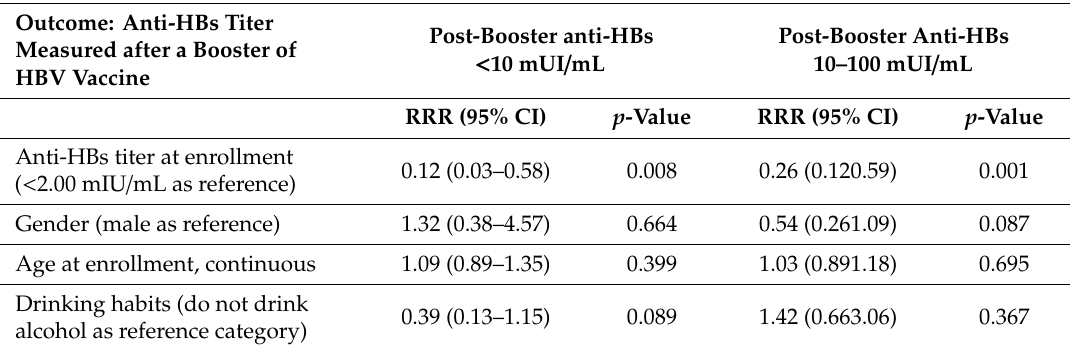
Table 4. Results of the multinomial regression analysis estimating predictors of the anti-HBs titer measured after a booster of HBV